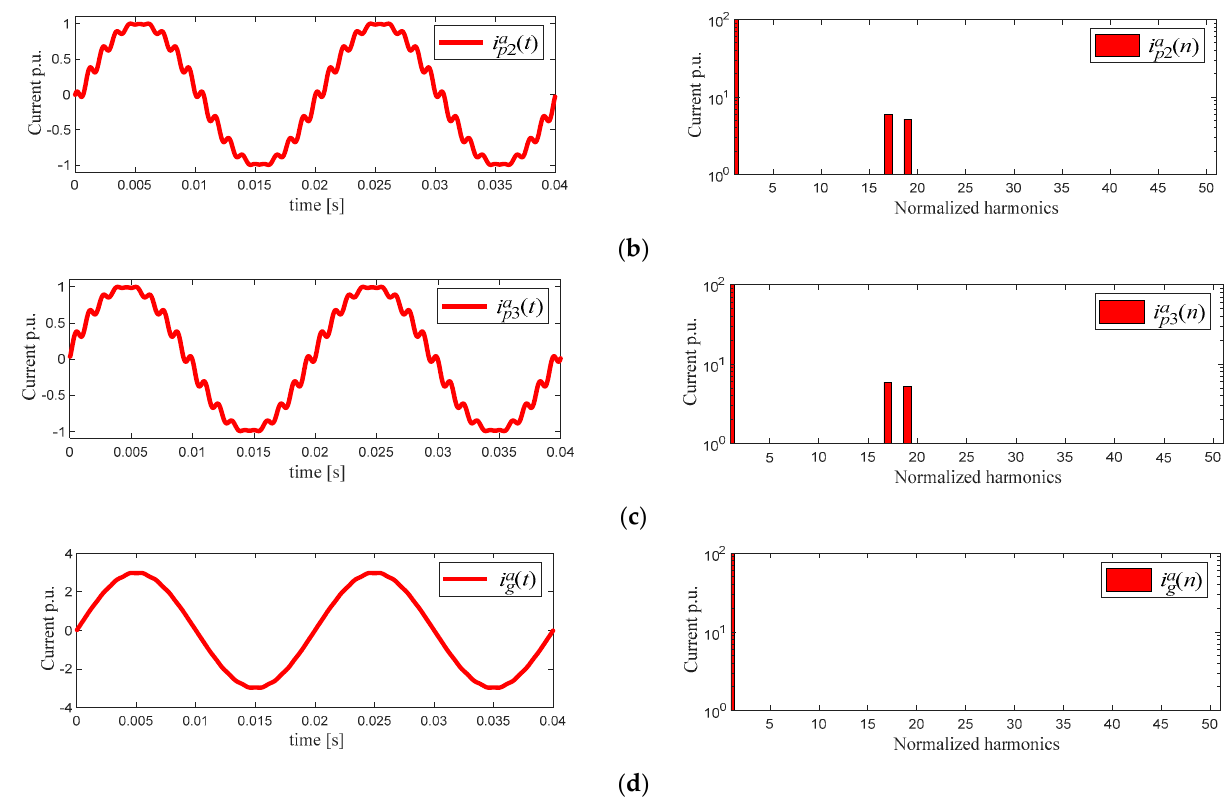
Figure 2. Input current references and harmonic content AFE rectifier for phase a . ( a ) AFE rectifier 1, ( b ) AFE rectifier 2, ( c ) AFE rectifier 3, ( d ) multicell AFE rectifier input current.